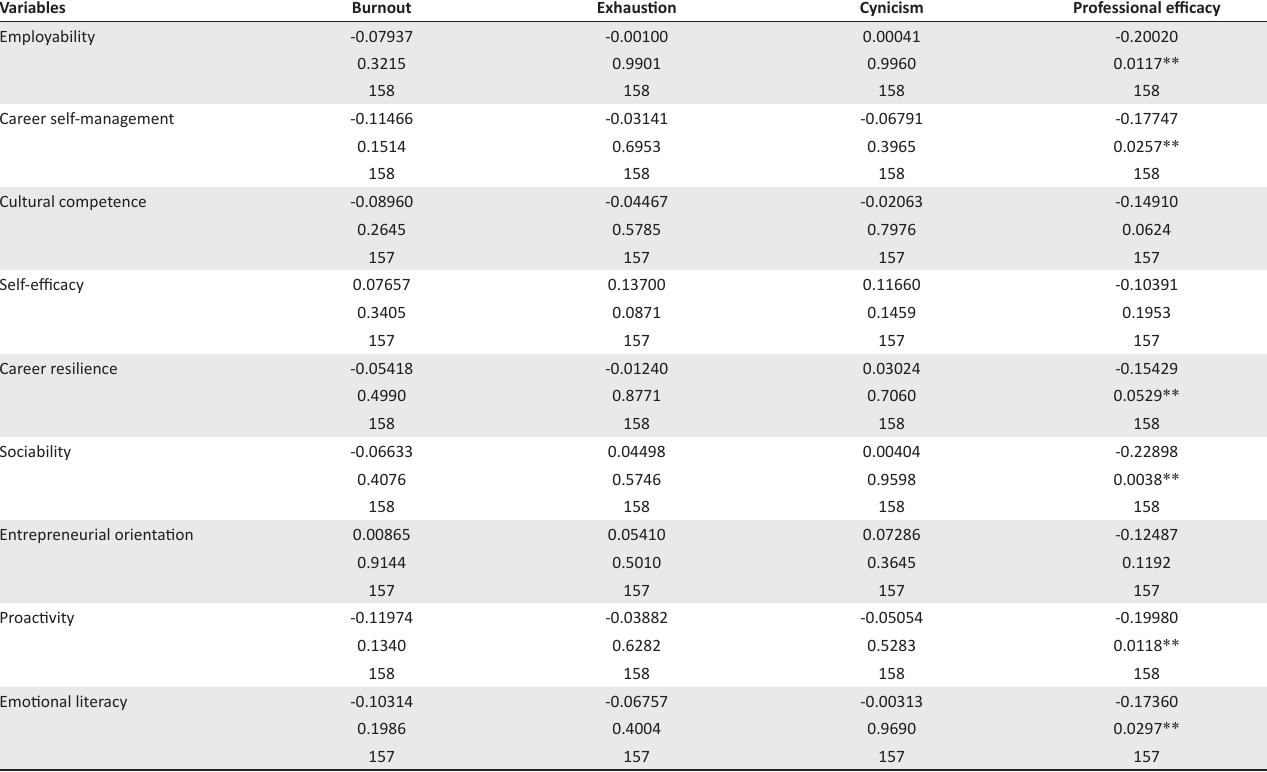
TABLE 2: Correlations between subscales of burnout and self-perceived employability: Pearson product-moment correlation coefficients, N = 158, Prob > | r | under H0: Rho = 0.